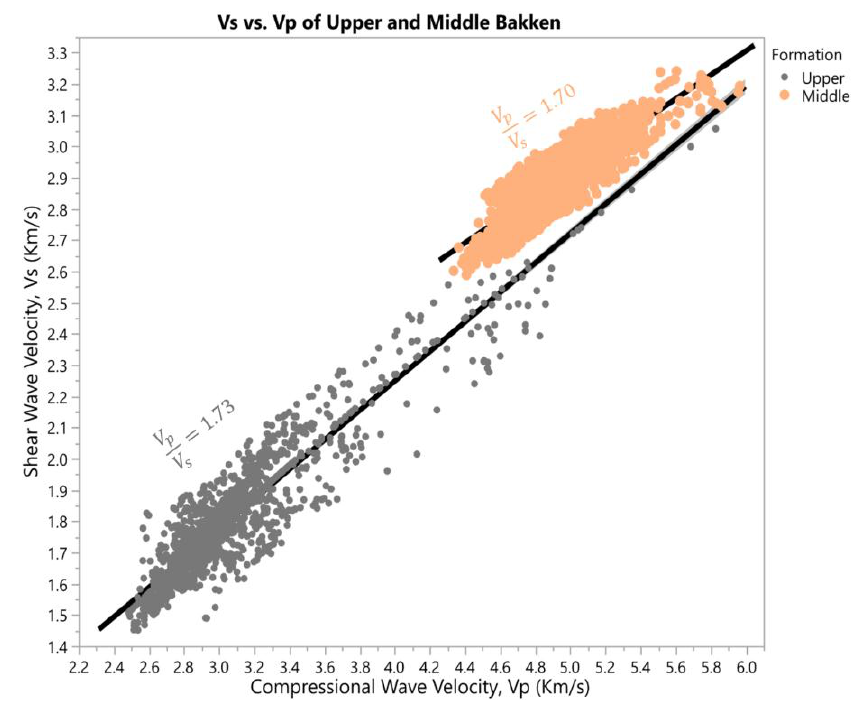
Figure 15. V p /V s ratio for the Upper and Middle Bakken Formation.